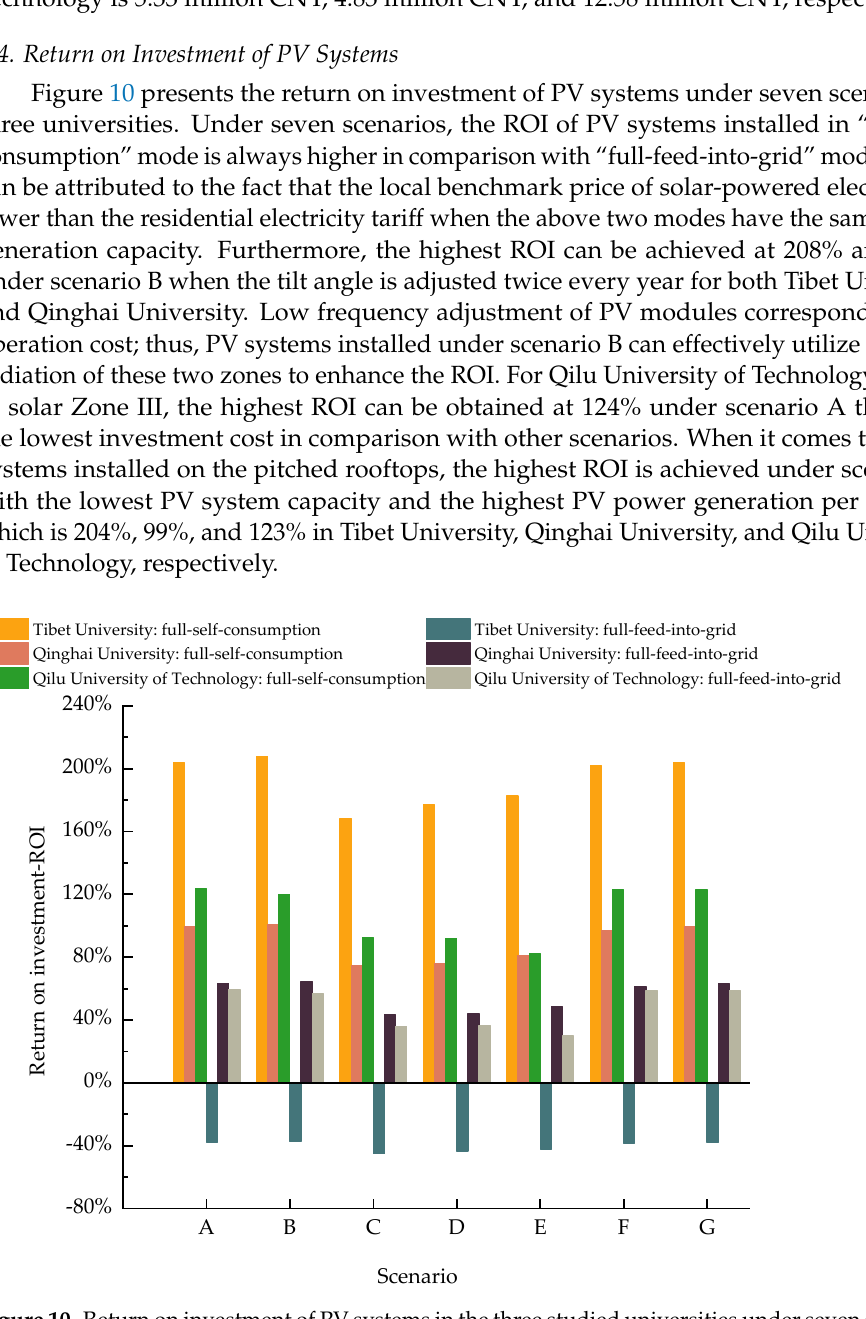
Figure 10. Return on investment of PV systems in the three studied universities under seven